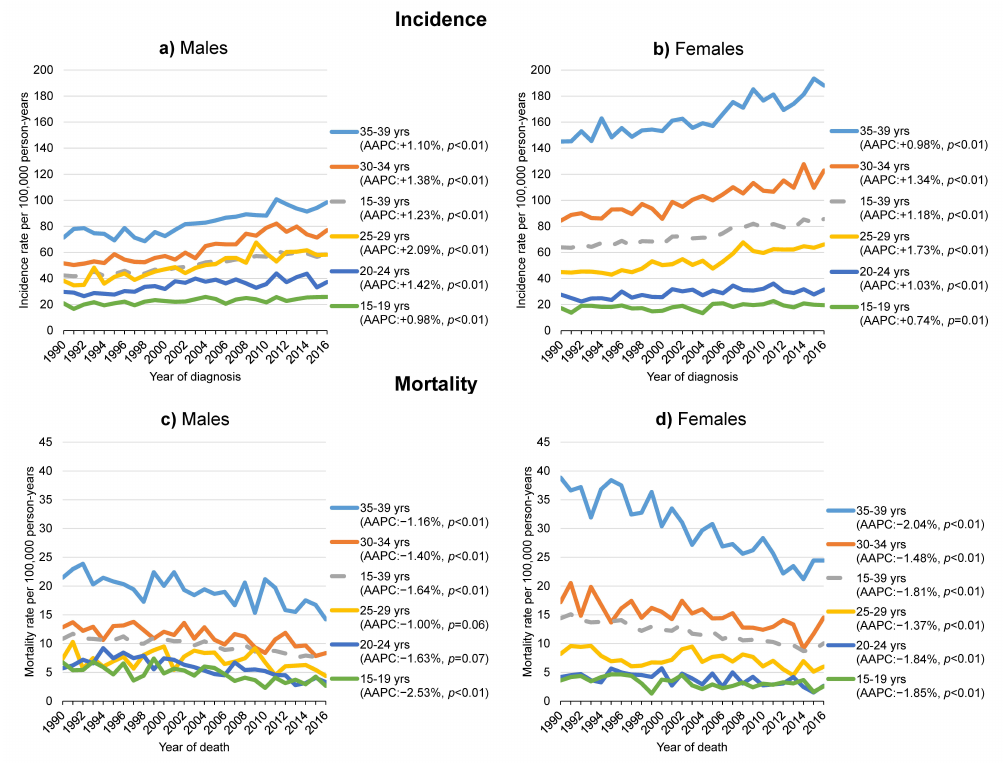
Figure 2. Age-standardised incidence and mortality rates per 100,000 person-years for ( a,c ) male and ( b , d ) female adolescents and young adults (AYAs) diagnosed with or passed away due to cancer in the Netherlands between 1990–2016. Rates were standardised using weights from the 1976 European standard population. Note the non-significant average annual percentage change (AAPC) estimates in panel c for male AYA cancer patients aged 20–24 and 25–29